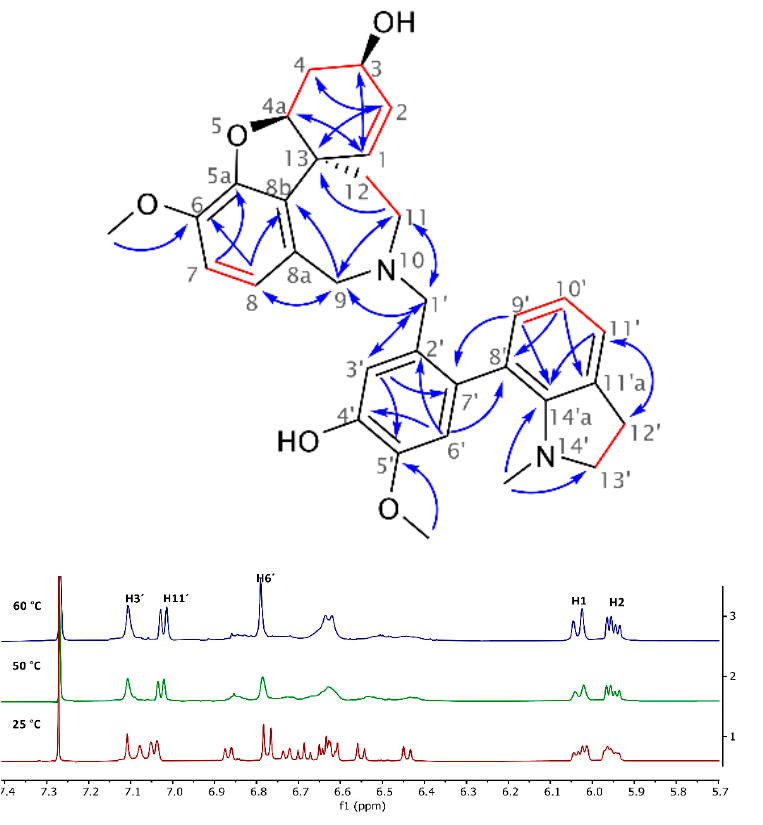
Figure 2. Key NMR correlations of 2 (red lines show gCOSY and gH2BC correlations, and blue arrows indicate interactions in the gHMBCAD experiment) and the aromatic region of its 1 H-NMR spectrum at different temperatures, which demonstrates coalescence of highlighted signals during dynamic NMR analysis (measured in CDCl 3